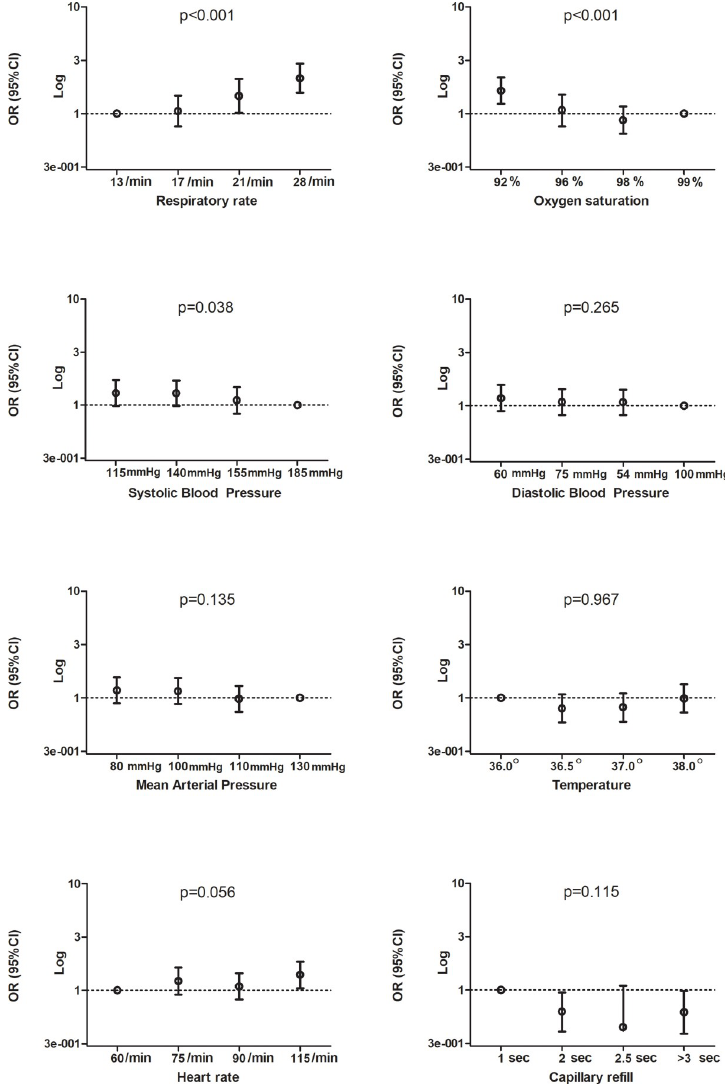
Fig 2. Quartiles of vital signs and their association with cognitive impairment. Abbreviations:, mmHg = millimetres of mercury, min = minute, = degrees celsius, sec: seconds, OR = odds ratio, 95%CI = 95% confidence interval, p = p-value, % = percentage. Y-axes is a logarithmic scale. The x-axes shows quartiles of the represented vital sign with the mean value within that category as label. The circle on the dotted line represents the reference category. Odds ratios and 95% CI’s can be found in S1 Table. Dot with bars represents the odds ratio with 95% confidence interval.